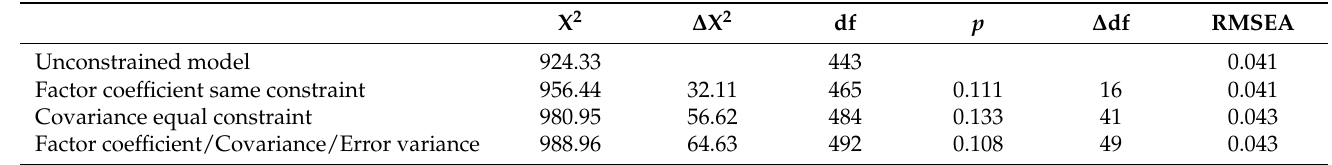
Table 12. Results of verification of measurement equivalence by